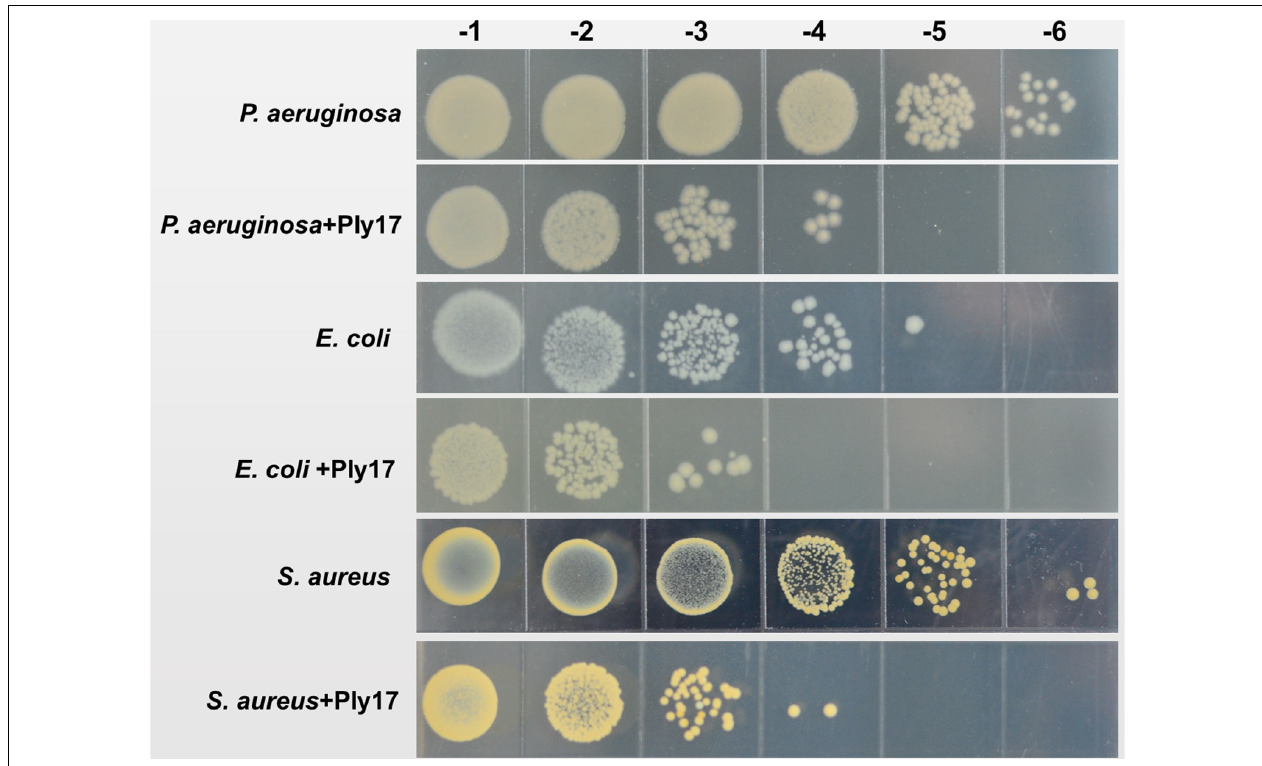
FIGURE 5 | Representative pictures of cell viability before and after Ply17 treatment. To measure viability, 10-fold dilutions of log phase bacteria and Ply17-treated cells were spotted onto agar plates. Representative pictures of P. aeruginosa PAO1, E. coli JM109, and S. aureus XN108 showed that Ply17 reduced the viable cell by ∼ 2 log